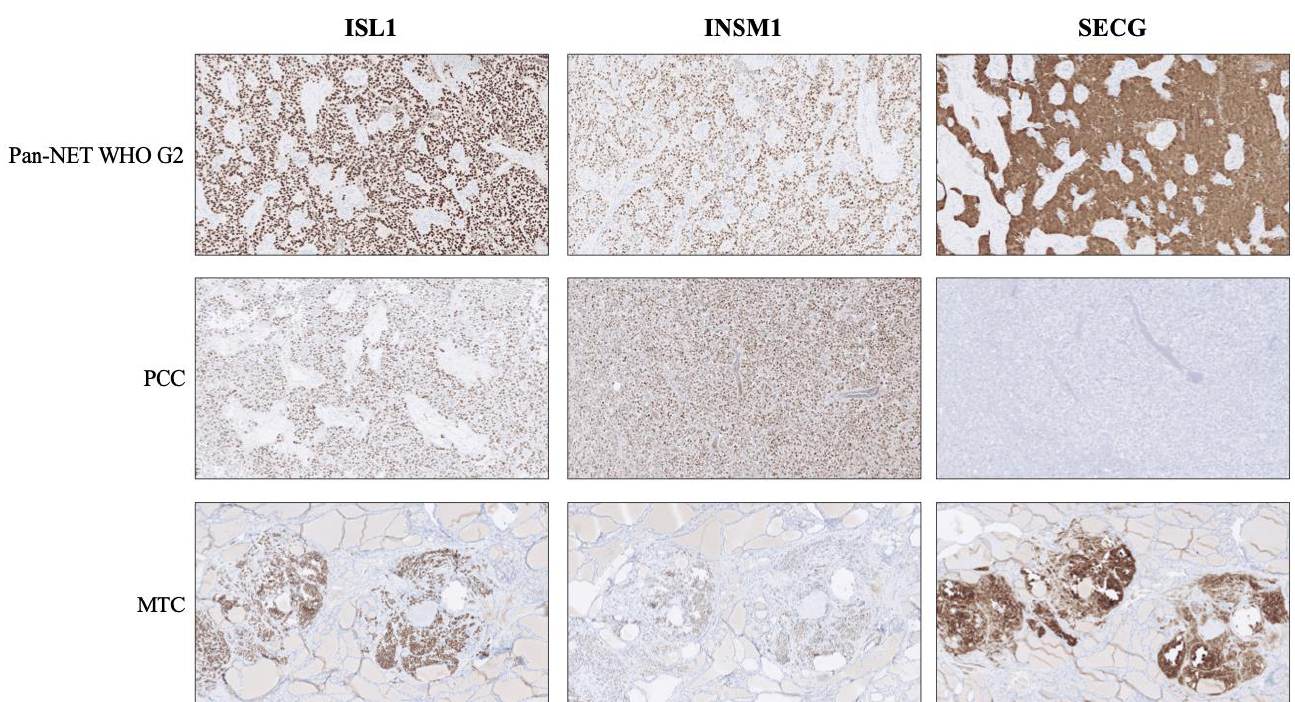
Figure 1. Expression of second-generation neuroendocrine markers ISL LIM Homeobox 1 (ISL1), INSM Transcriptional Repressor 1 (INSM1) and Secretagogin (SECG) in various neuroendocrine tumors. Top row: A pancreatic neuroendocrine tumor (Pan-NET) WHO grade 2 exhibiting distinct and diffuse nuclear immunoreactivity for all three markers, in addition to cytoplasmic SECG. Middle row: A pheochromocytoma (PCC) depicting the traditional staining pattern of this tumor type; positivity for ISL1 and INSM1, but absence of SECG. Bottom row: Medullary thyroid carcinoma (MTC) specimen with positive expression for all three markers. Note the absent staining in the surrounding thyroid parenchyma.